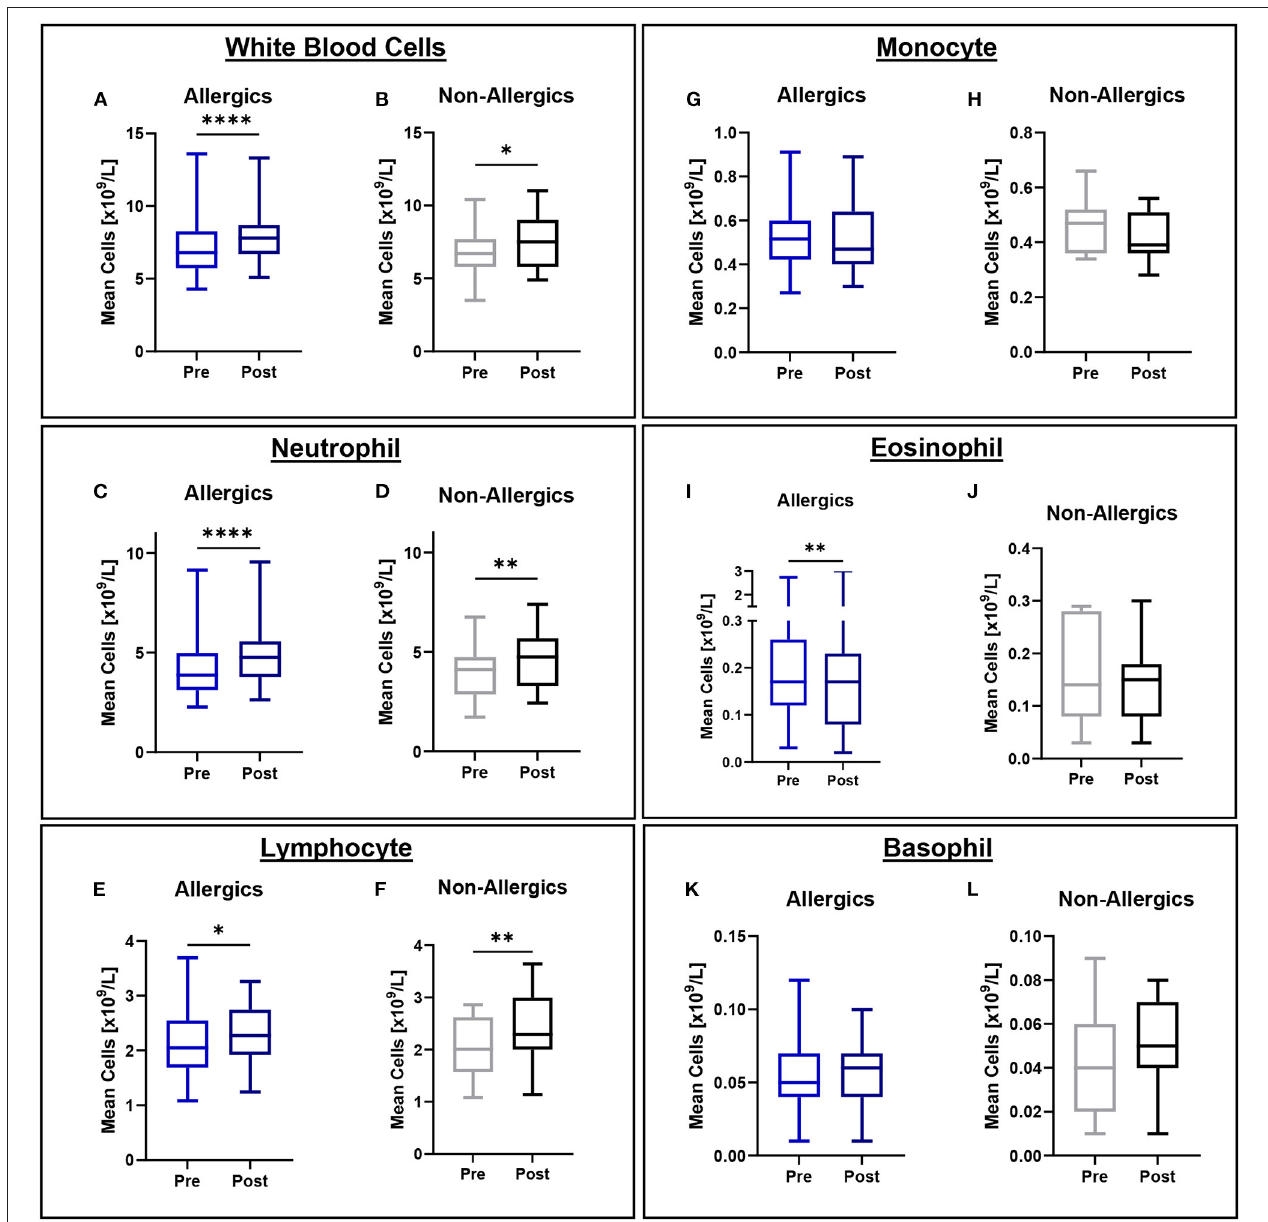
FIGURE 3 | White blood cell counts in peripheral blood collected pre- and post-exposure for HDM-allergic and non-allergic participants. Concentrations of white blood cells (A,B) , neutrophils (C,D) , lymphocytes (E,F) , monocytes (G,H) , eosinophils (I,J) , and basophils (K,L) were evaluated pre- and post-HDM exposure for allergic and non-allergic participants in these paired analyses. Eosinophil concentrations were significantly decreased only for HDM-allergic participants (I) . * , p < 0.05, ** , p < 0.01, **** , p < 0.0001.